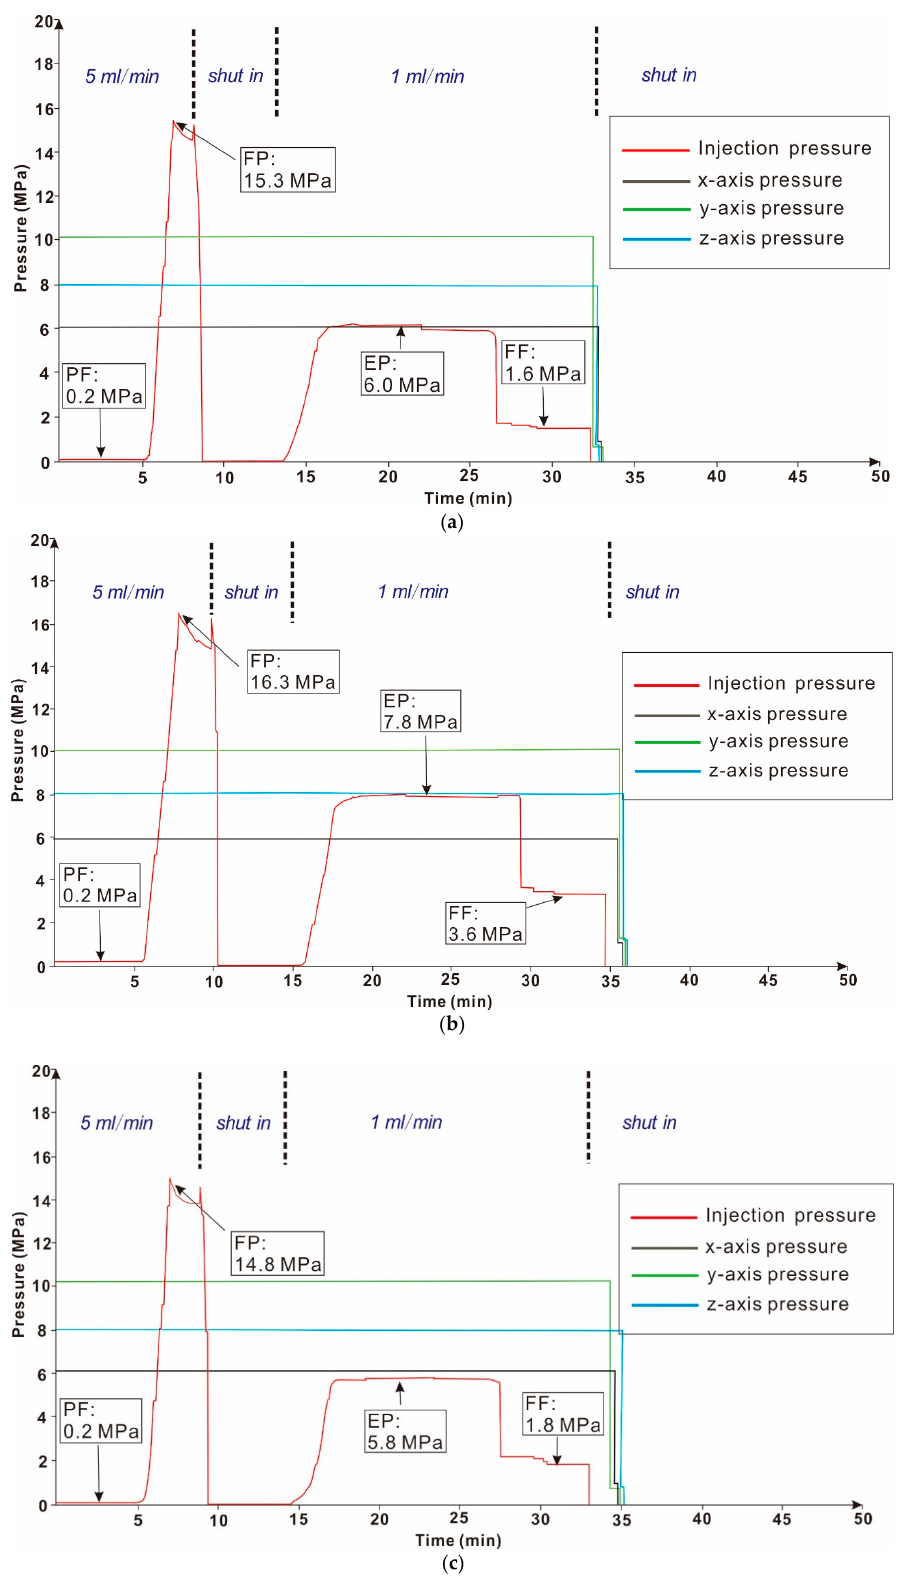
Figure 9. Pressure curve variations of H1 ( a ), H2 ( b ), and F1 ( c ), during the test. PF is pipe friction, FP is fracturing pressure, EP is extension pressure, and FF is fracture friction. is fracturing pressure, EP is extension pressure, and FF is fracture